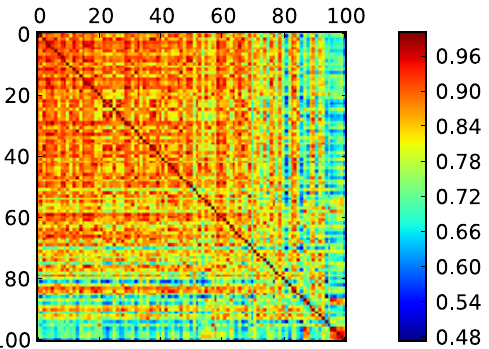
Fig. 5. Matrix of correlation between all observed ozone peaks (on network 1) and the corresponding model-concentrations. The mod- els are sorted according to the RMSE (from the best to the worst value). Table 6. Description of the best model.